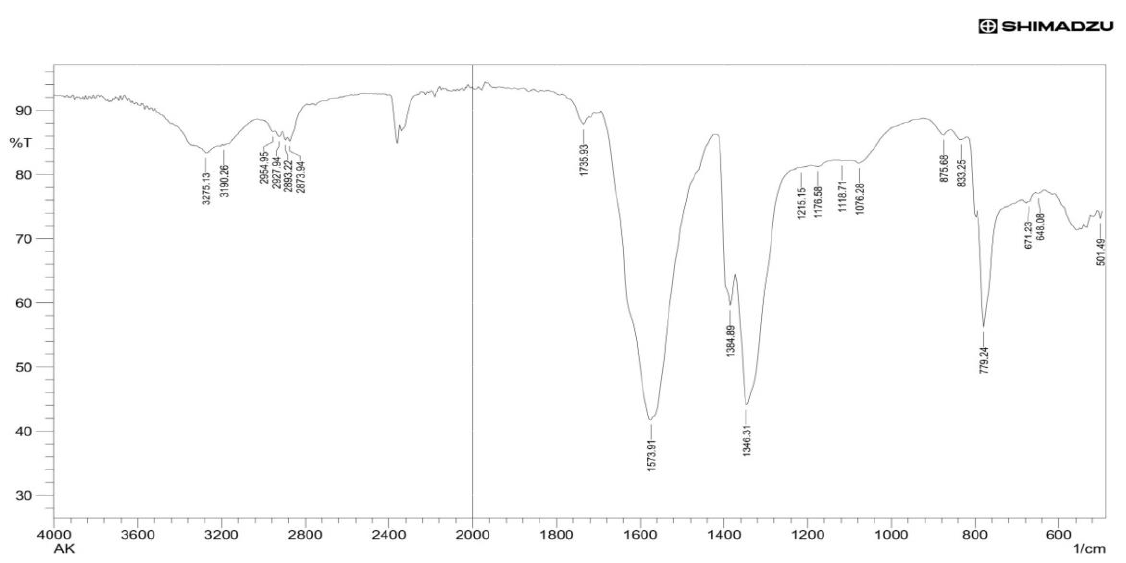
Figure 16. FTIR spectrum of isolated ak